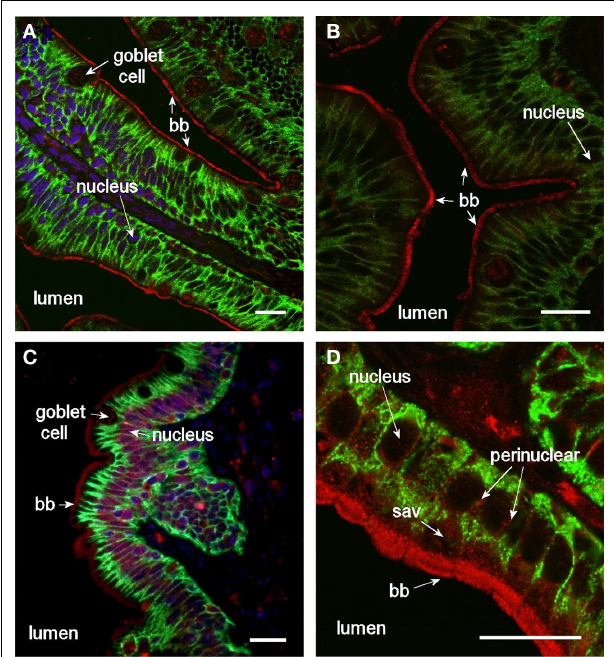
FIGURE 9 | Confocal images (63 × objective) showing localization of Aqp8ab in middle (A,B) and posterior (C,D) segments of intestine from SW-acclimatedAtlantic salmon. Sections were incubated with a cocktail of antibodies against Aqp8ab (red), Na + , K + -ATPase (green), and nuclei were counterstained with DAPI [blue, in (A–C) ]. Lumen, goblet cells, nuclei, brush border, (bb) and sub-apical vesicles (sav) are indicated. Size bar = 20 μ m.